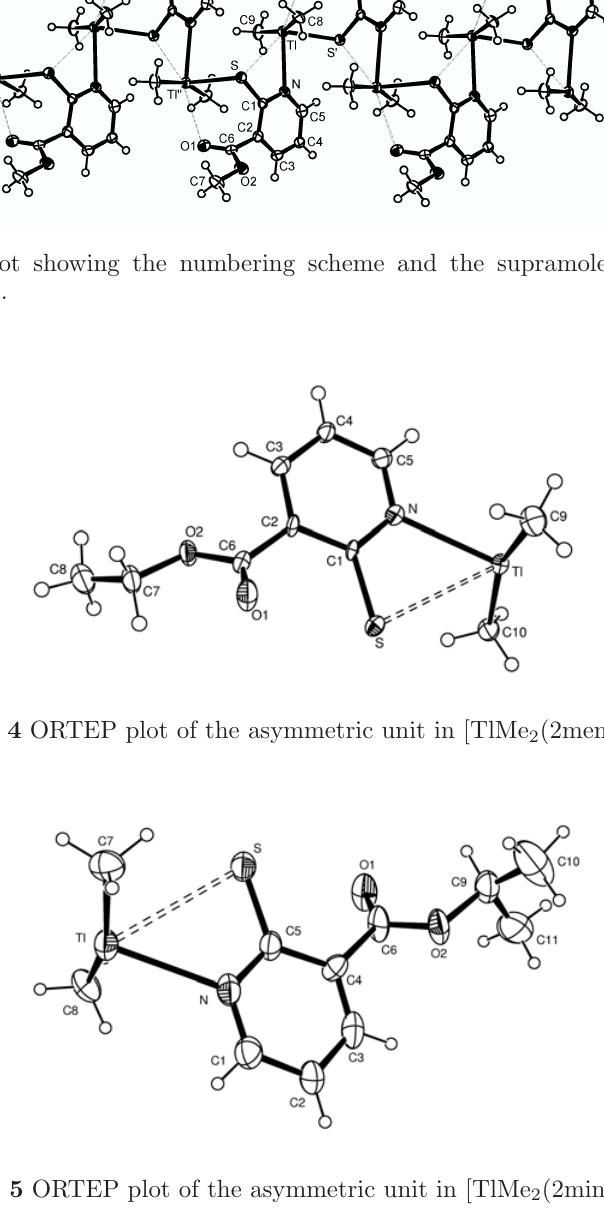
Fig. 5 ORTEP plot of the asymmetric unit in [TlMe 2 (2min)]( 4